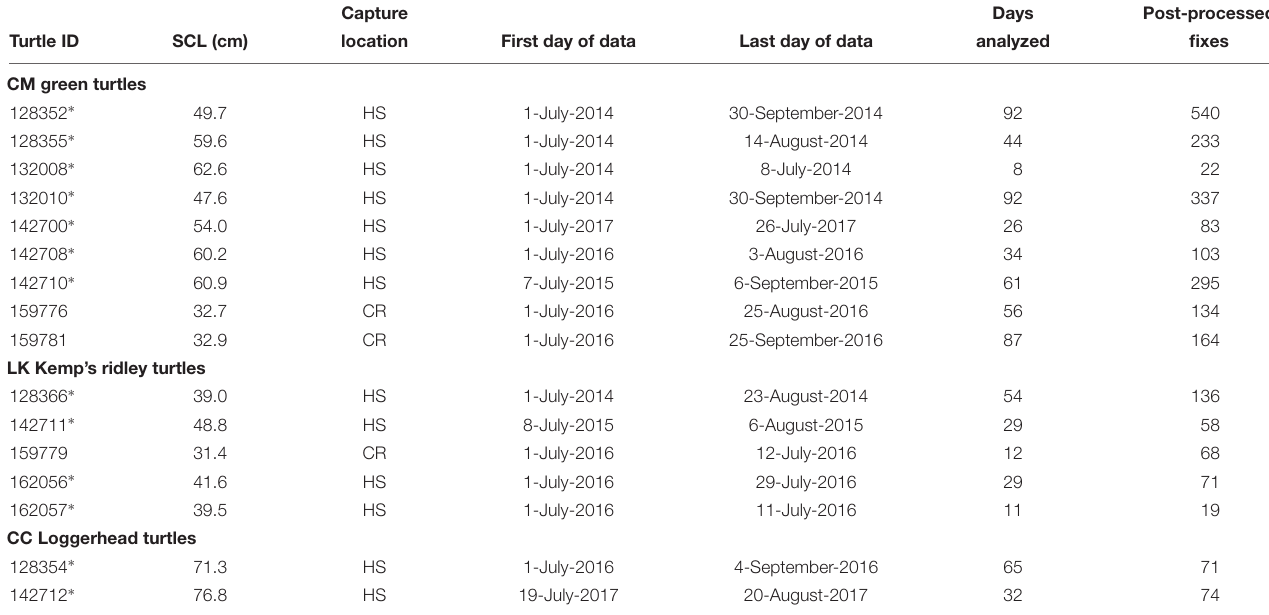
TABLE 1 | Summary of marine turtles tracked between July and September (2014–2017) in the Crystal River region, United States. Capture Days Post-processed SCL (cm) location